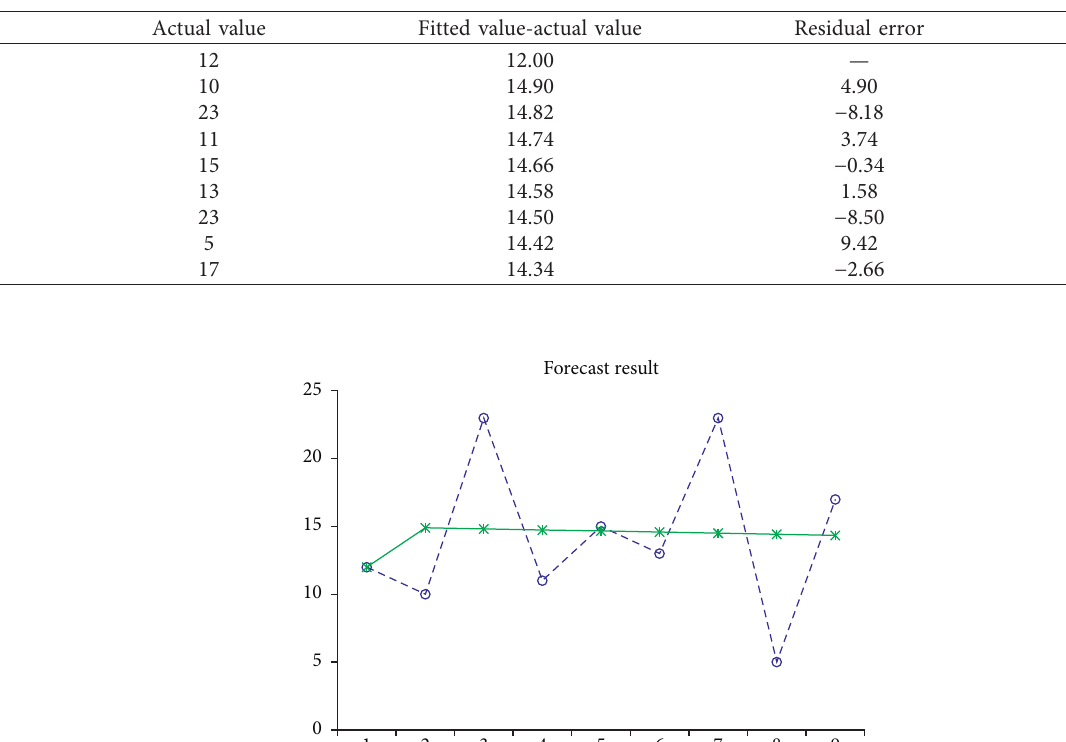
Table 9: The GM (1, 1) fitted value of original sequence.